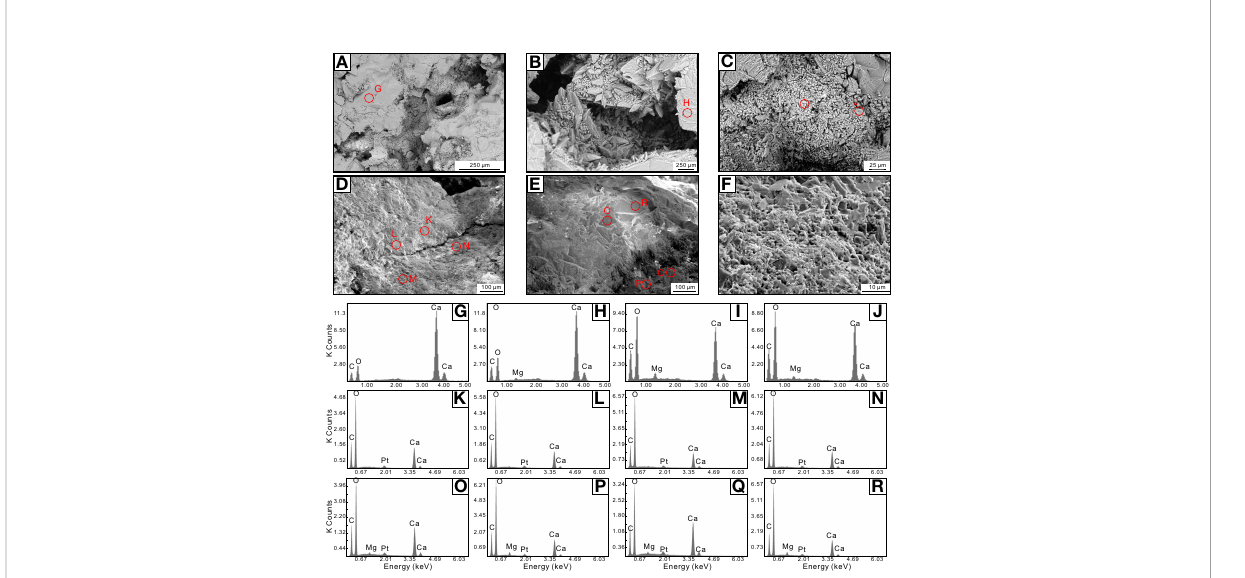
FIGURE 5 SEM images of calcareous speleothem samples (A – F) and geochemical composition (G – R) . (A – C) Secondary cemented pores. (D, E) Calcite crystals are